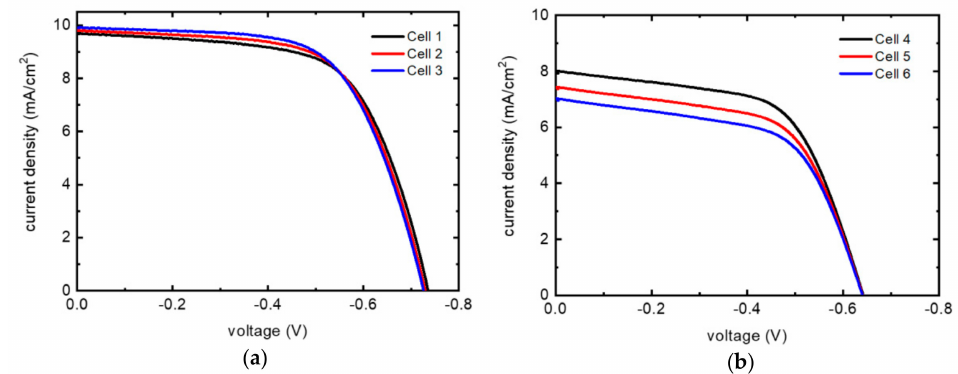
Figure 9. Current density–voltage (J-V) curves at scan rate: 20 mV/s. ( a ) HSE electrolyte ( b ) Home- made Co-based